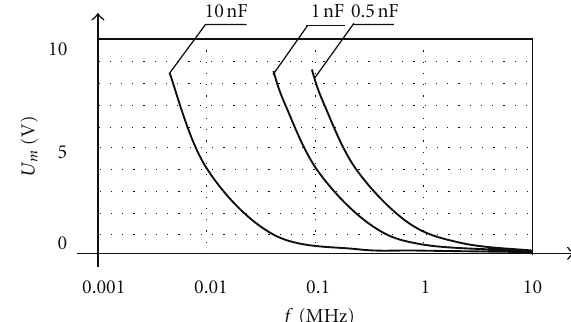
Figure 6: Dependence of maximum amplitude of the integrator output voltage on signal frequency.